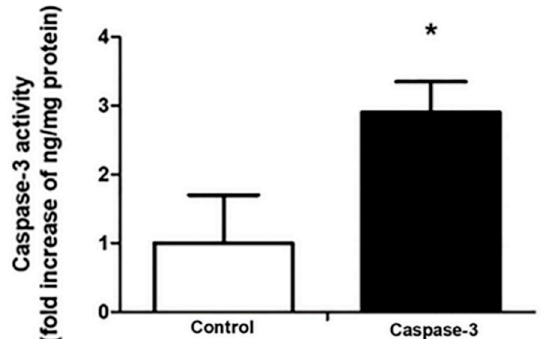
Figure 6. Effects of CSEE on caspase-3 activity. The SH-SY5Y cells were treated with 20 µg/mL of